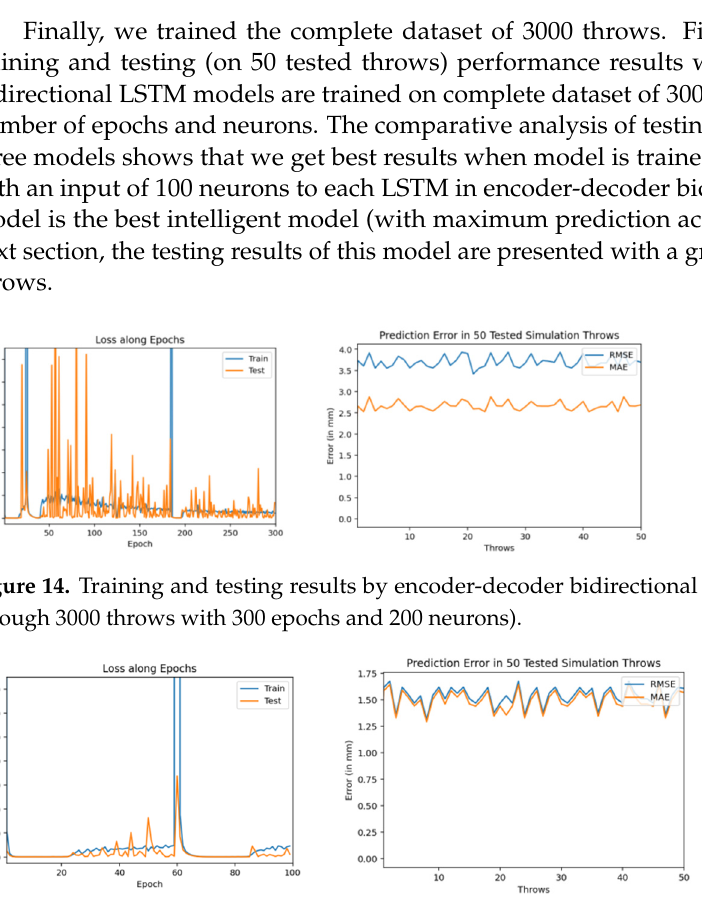
Figure 13. Training and testing results by encoder-decoder bidirectional LSTM deep NN (trained through 1000 throws with 50 epochs and 100 neurons).